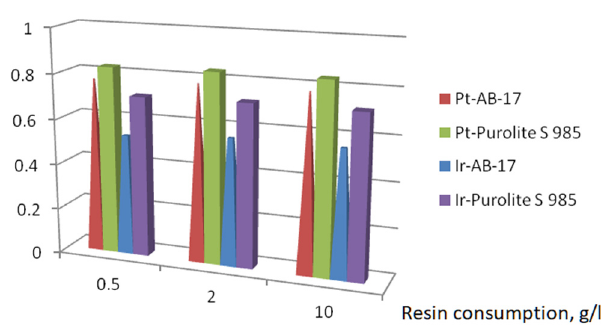
Figure 6. Platinum and iridium sorption from production sulfate-chloride solutions. Solution com- position, g/L: 25 NaCl, 25 HCl, 25 H 2 SO 4 , 3.4 Fe, 1.2 g/L Mg, 5.6 mg/L Pt, 1.2 mg/L Ir. Sorbent con- sumption of 0.5–10